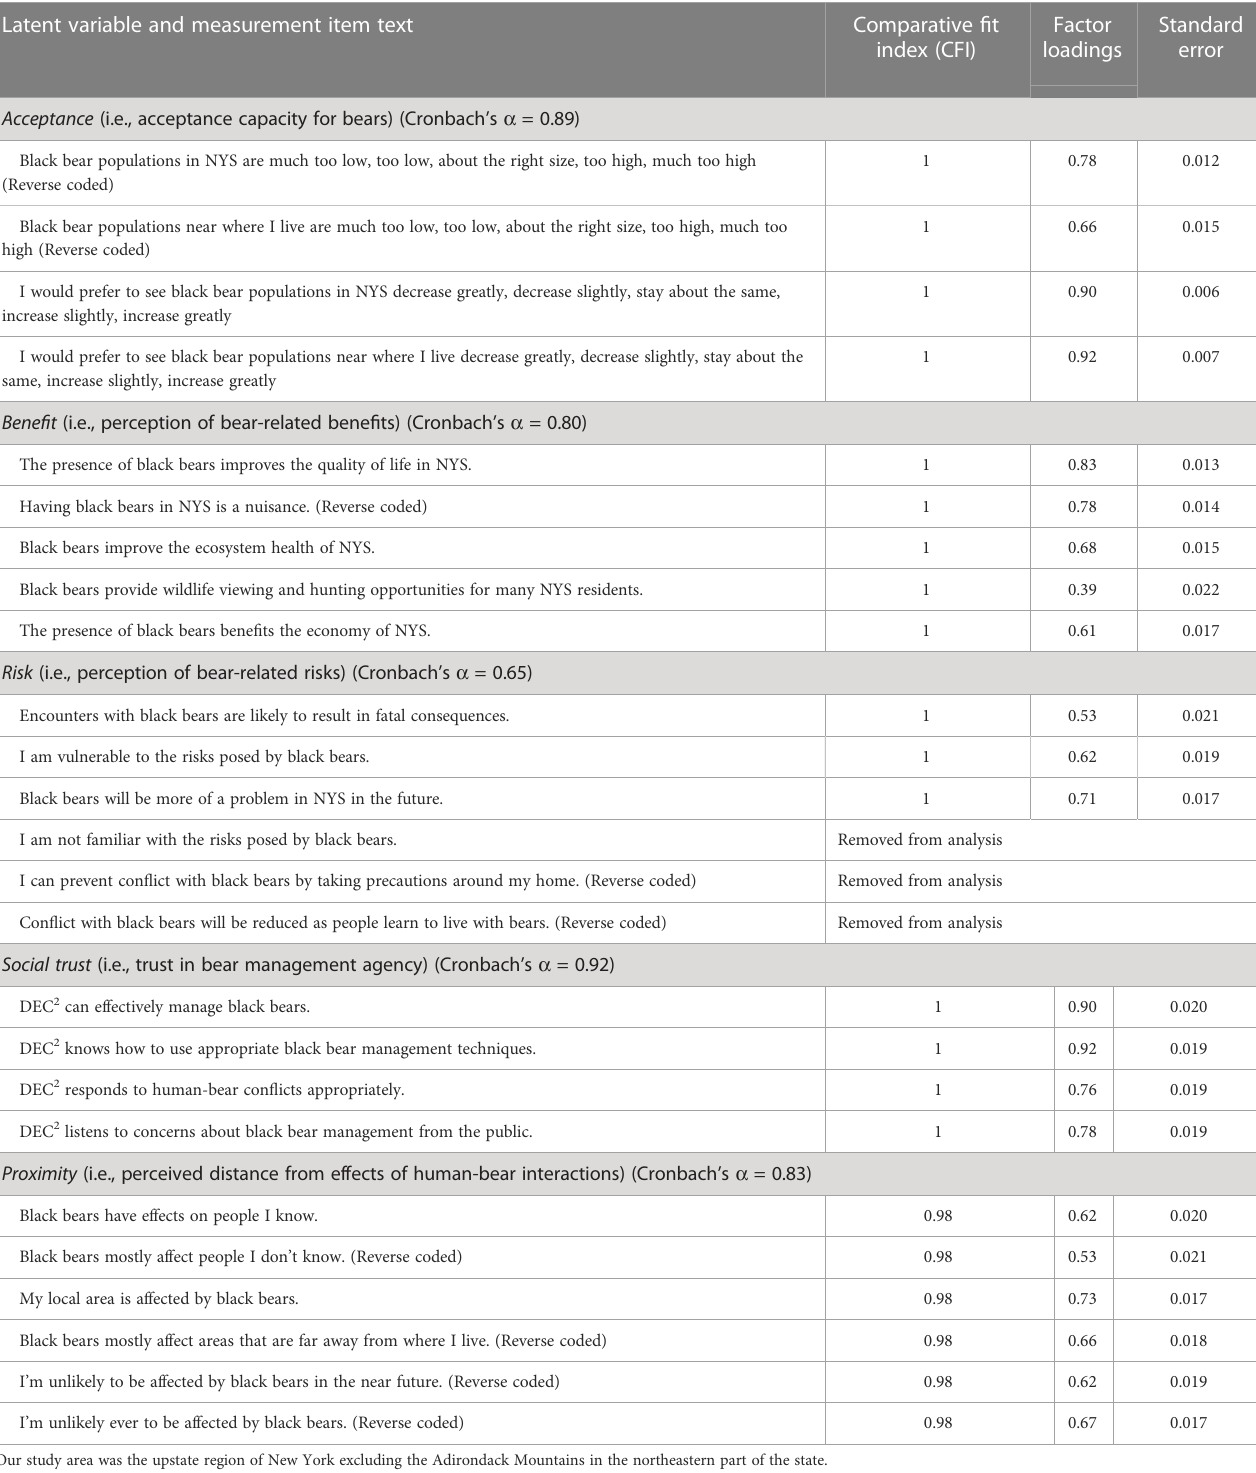
TABLE 1 Scale reliability and factor loadings of items to measure the latent variables acceptance, bene fi ts, risks, personal control, proximity, and social trust. Latent variable and measurement item text Comparative fi t